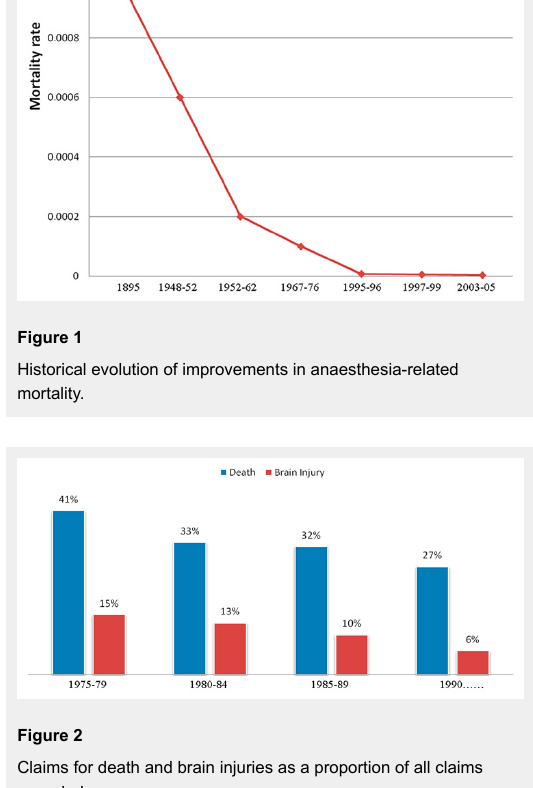
Claims for death and brain injuries as a proportion of all claims